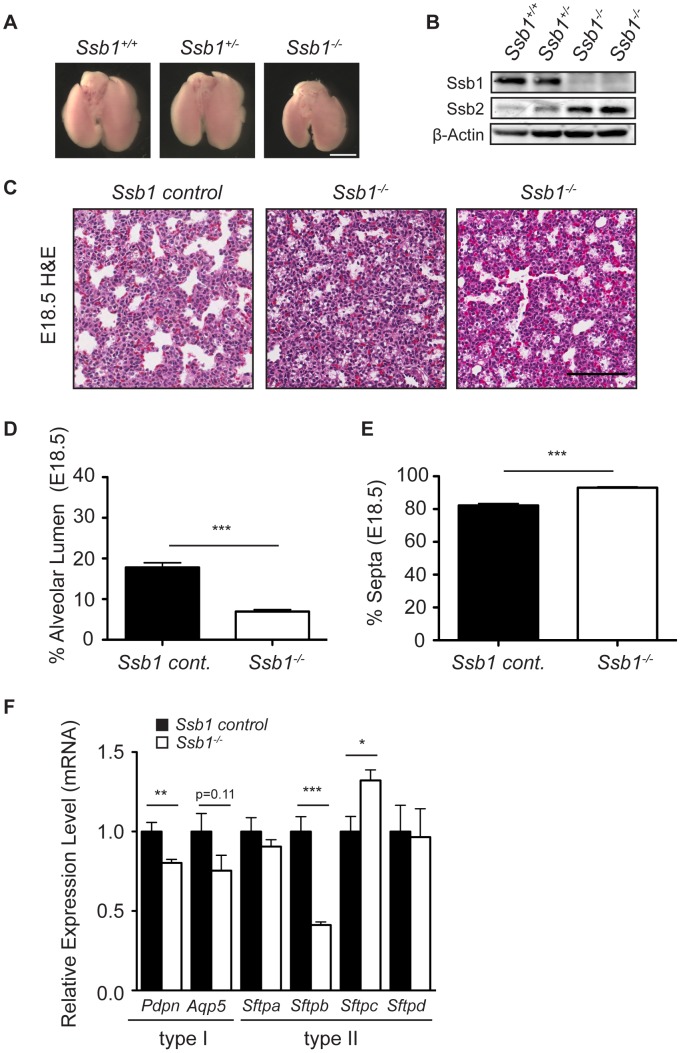
Distal lung differentiation defects in Ssb1
−/− embryos.(A) Representative image showing the comparison of lung size and morphology of E18.5 Ssb1
+/+, Ssb1
+/− and Ssb1
−/− embryos. Scale bar = 2 mm. (B) Protein level of Ssb1, Ssb2 and Actin in Ssb1
+/+, Ssb1
+/− and Ssb1
−/− E18.5 lungs. (C) Haematoxylin and eosin staining showing morphology of alveolar lumen formation and intra-alveolar septae thickness in Ssb1 control (Ssb1
+/+, Ssb1
+/−) and Ssb1
−/− E18.5 embryos. (D) Quantitation of alveolar lumen area and (E) intra-alveolar septa area in Ssb1 control (Ssb1
+/+, Ssb1
+/−) and Ssb1
−/− embryos. Data represent the mean ± SEM (n = 3 control and 4 Ssb1
−/− embryos from 2 litters. ***P<0.001, student's t-test). (F) qRT-PCR of Type I and Type II alveolar epithelial cell markers in Ssb1 control (Ssb1
+/+, Ssb1
+/−) and Ssb1
−/− E18.5 lungs. Data represent mean ± SEM from 4 embryos per condition (*P<0.05, **P<0.01,***P<0.001; student's t-test).